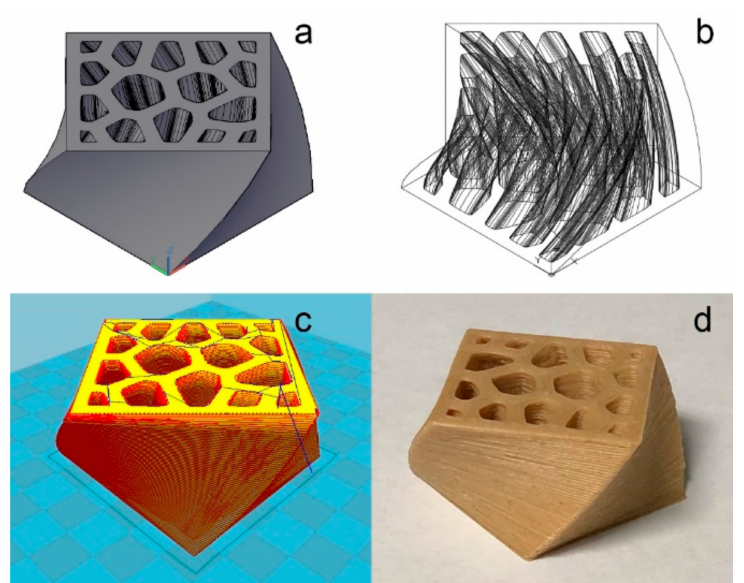
Figure 2. An illustration of the typical AM process. ( a ) 3D model of the desired product; ( b ) “wireframe” display of the desired product; ( c ) model after slicing into layers by the CURA software; ( d ) desired product constructed using fused deposition modeling (FDM) 3D